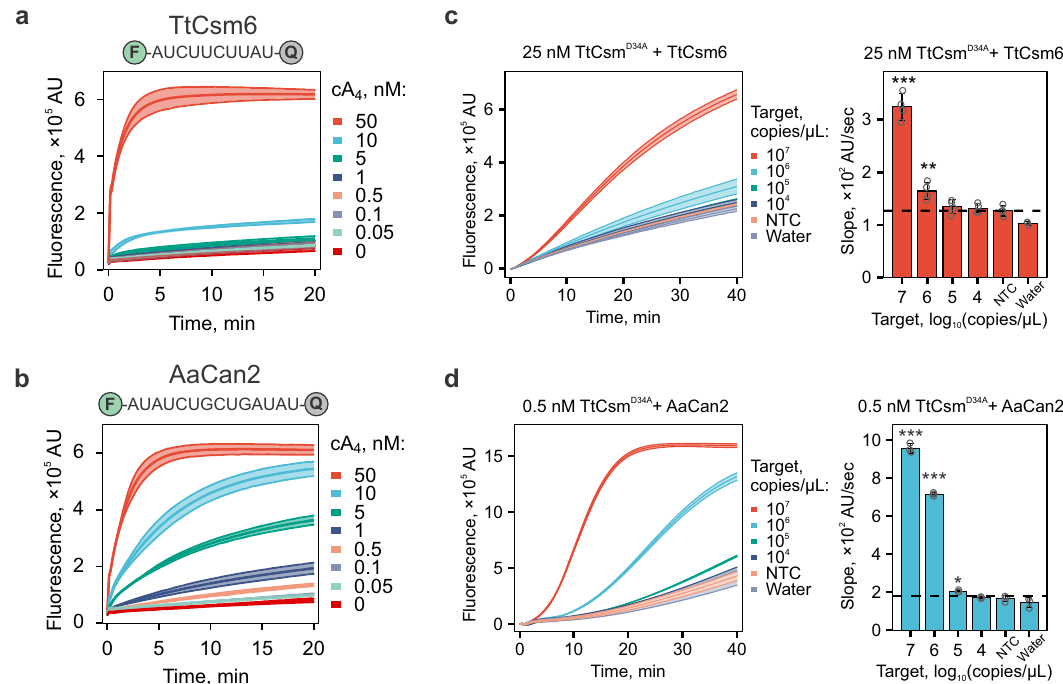
Fig. 3 | IncorporationofCan2 nuclease improvessensitivityofCsm-basedRNA from nasopharyngeal swab patient sample negative for SARS-CoV-2. Cleavage of fl uorescent RNA reporter was detected by measuring fl uorescence every 10s in a detection. a TtCsm6 (300nM) and b AaCan2 (300nM) cleavage assays with fl uorescent ssRNA reporter (top) in the presence of varying cA real-time PCR instrument (left). Data were plotted as mean of four replicates. 4 activator con- Simple linear regression was used to calculate slopes for linear regions of the centrations (shown with colors). Data are shown as the mean (center line) of three curves.Barsshowmeanvalues( n =4)±S.D.(right).Datawasanalyzedwithone-way replicates ± S.D. (ribbon). The optimal fl uorescent reporter (top) was determined ANOVAfollowedbymultiplecomparisonstoNTCsampleusingone-tailedpost-hoc using RNA library screen in Supplementary Fig. 6. TtCsm RNA detection coupled Dunnett ’ s test. *** p <0.001; ** p <0.01; * p <0.05. AU=arbitrary units. Source data with TtCsm6- ( c ) and AaCan2-based ( d ) assays wereperformed using samples with are provided as a Source Data fi target RNA concentrations ranging from 10 7 to 10 4 copies/ µ L. Samples were pre- pared by spiking IVT fragments of SARS-CoV-2 N gene into total RNA extracted